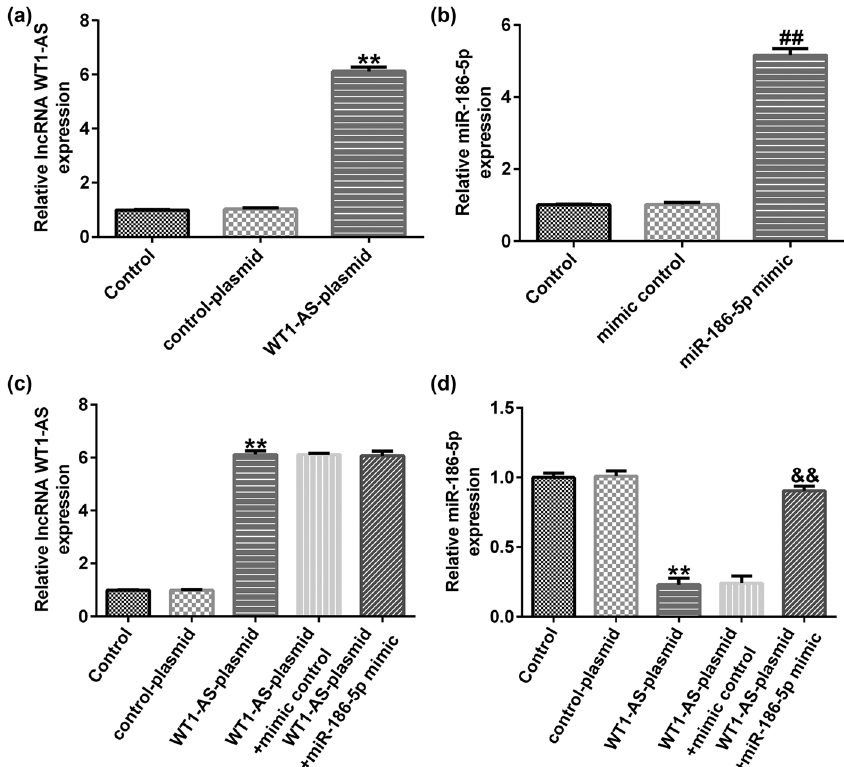
Figure 3: lncRNA WT1 - AS negatively regulates miR - 186 - 5p expression levels in SH - SY5Y cells. ( a ) RT - qPCR analysis results showing WT1 - AS expression levels in SH - SY5Y cells transfected with the control or WT1 - AS - plasmids. ( b ) RT - qPCR analysis results showing miR - 186 - 5p expression levels in SH - SY5Y cells transfected with the control or miR - 186 - 5p mimics. ( c ) RT - qPCR analysis showing the expression levels of WT1 - AS in SH - SY5Y cells transfected with the control plasmid, miR - 186 - 5p mimics, WT1 - AS plasmid + control mimics, or WT1 - AS plasmid + miR - 186 - 5p mimics. ( d ) RT - qPCR analysis showing the expression levels of miR - 186 - 5p in SH - SY5Y cells transfected with the control plasmid, miR - 186 - 5p mimics, WT1 - AS plasmid + control mimics, or WT1 - AS plasmid + miR - 186 - 5p mimics. ** P < 0.01 vs control plasmid group; ## P < 0.01 vs control mimics group; && P < 0.01 vs WT1 - AS plasmid + control mimics group. GraphPad Prism 6.0 software ( GraphPad Software, Inc. ) was used for creation of the fi